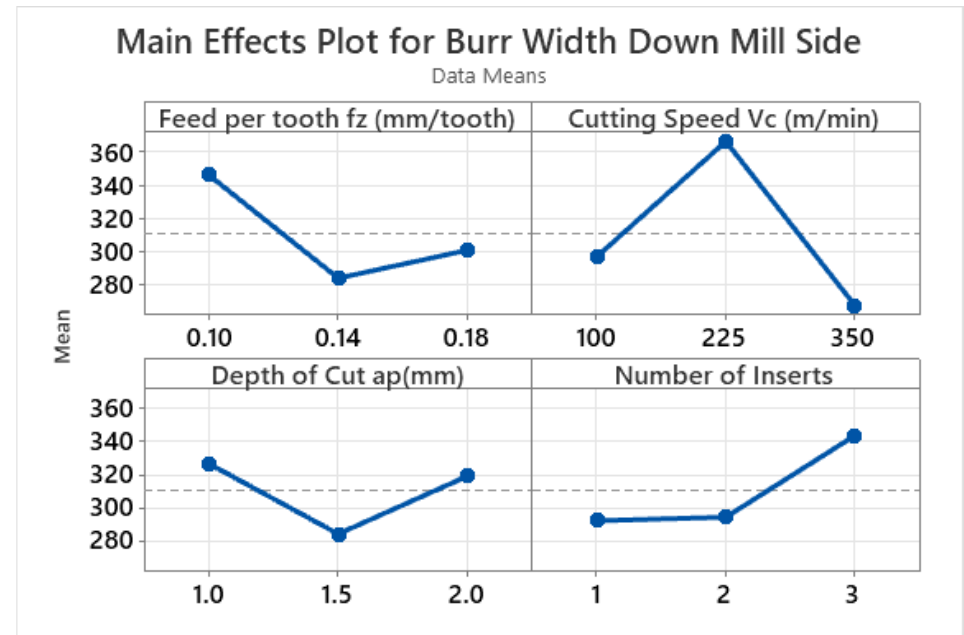
Figure 5. Main effect plots for burr width on down-milling side (µm).